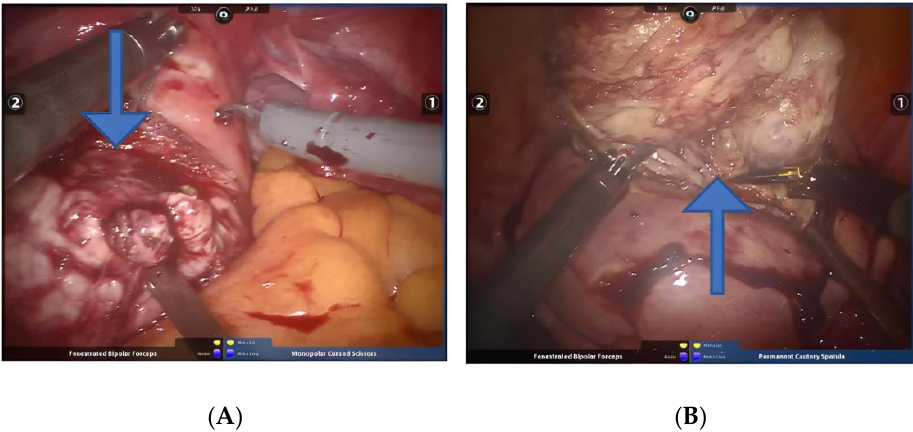
Figure 8. ( A , B ) Resection of cervical fibroids. Arrows point to the location of the cervical fibroids.